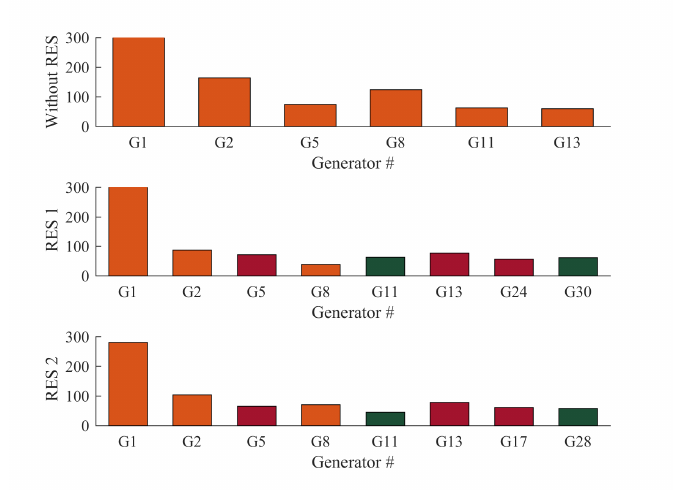
Figure 10. Fuel cost (USD/hr) for IEEE 30-bus system, IEEE 30-bus Modified (1) and IEEE 30-bus Modified